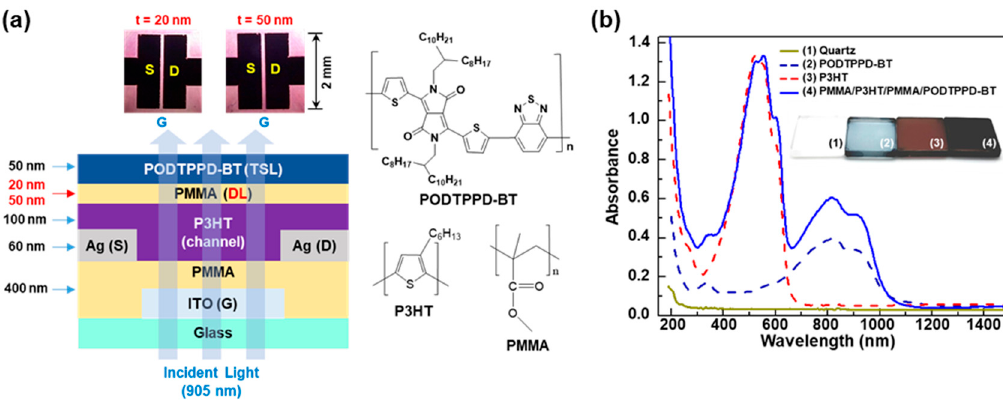
Figure 1. ( a ) Illustration of the cross-sectional structure of the device (see chemical structures on the right) and optical microscope images of the channel part for the near-infrared-sensing organic phototransistors (NIR-OPTRs) with the channel/dielectric/sensing (CDS) structures consisting of poly(3-hexylthiophene) (P3HT)/poly(methyl methacrylate) (PMMA)/poly[{2,5-bis-(2-octyldodecyl)- 3,6-bis-(thien-2-yl)-pyrrolo[3,4-c]pyrrole-1,4-diyl}-co-{2,2 ′ -(2,1,3-benzothiadiazole)-5,5 ′ -diyl}] (PODTPPD-BT) triple layers (note that two different thicknesses (t = 20 nm and t = 50 nm) were applied for the PMMA dielectric layers (DLs)). ( b ) Optical absorption spectra of films coated on quartz (1) substrates: (2) PODTPPD-BT (50 nm), (2) P3HT (100 nm), (3) PMMA/P3HT/PMMA/PODTPPD-BT (CDS). Inset photographs show the color difference of films.